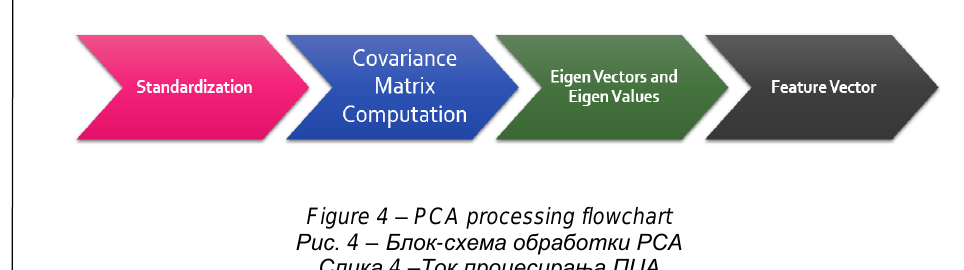
Figure 4 – PCA processing flowchart Рис. 4 – Блок-схема обработки